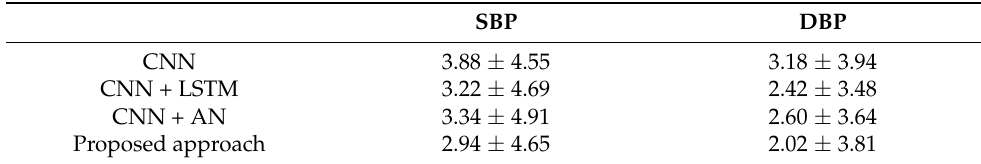
Table 5. Experimental results measured by using